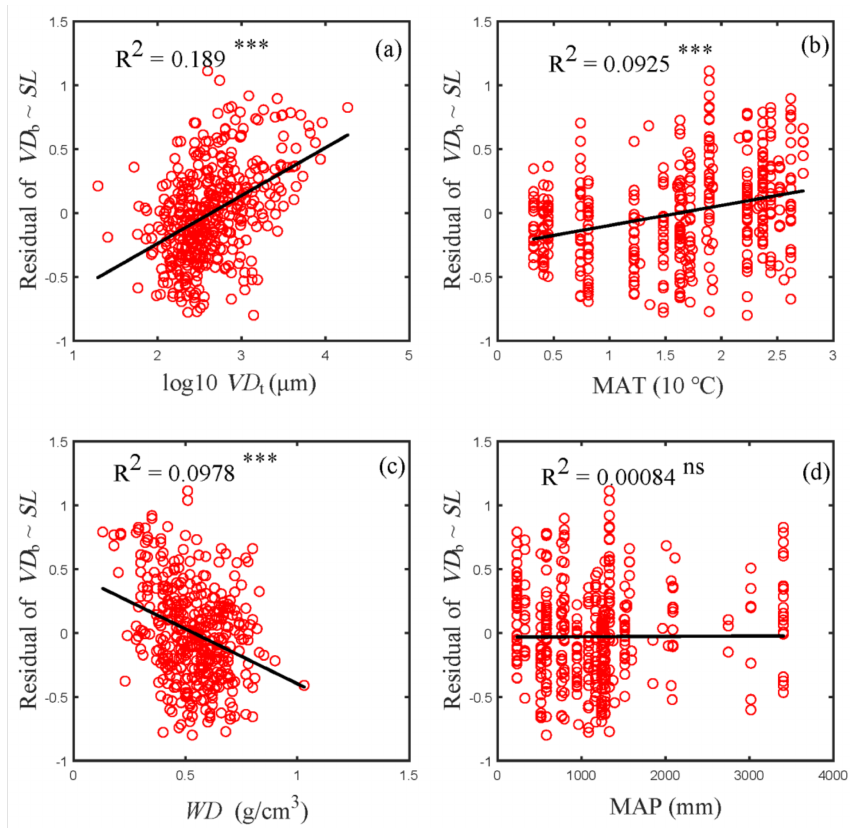
Figure 4. Relationship between residual variation in VD b and VD t ( a ), MAT ( b ), WD ( c ) and MAP ( d ). Residual variation of VD b was obtained after eliminating the contribution of SL to VD b through linear regression. R 2 is indicated in each panel. Asterisks indicate levels of significance (ns, p > 0.05; *** p < 0.001). Abbreviations for traits and environmental variables are the same as in Table 1.